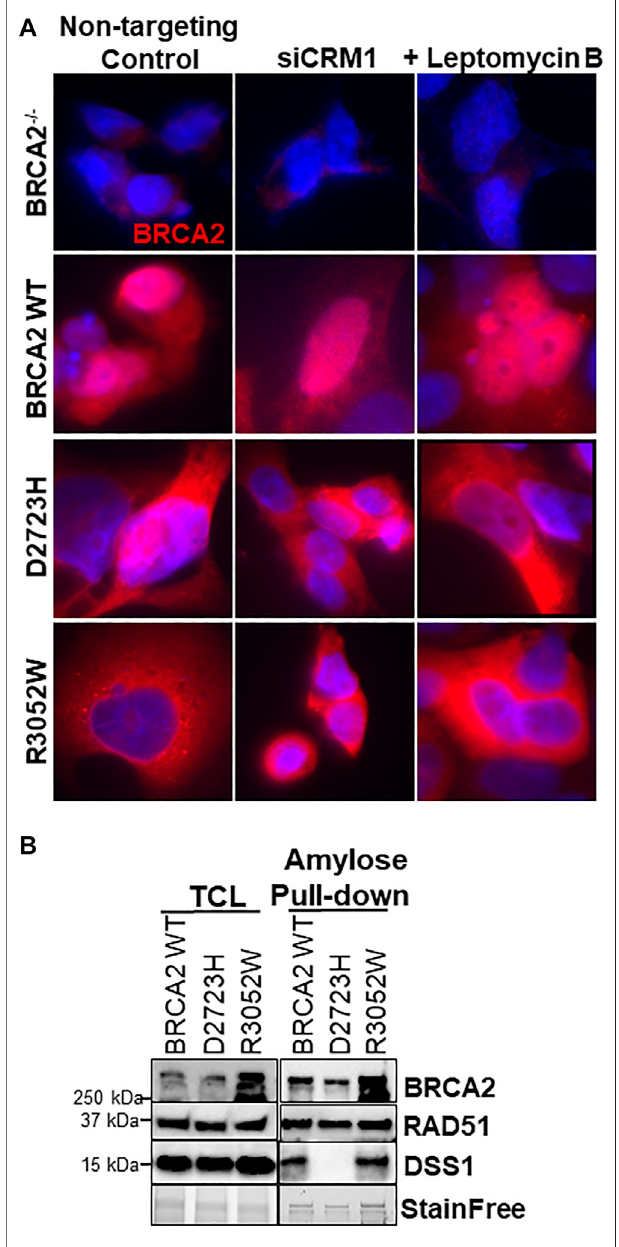
FIGURE 4 | R3052W cytoplasmic localization is not altered by CRM1 depletion or leptomycin treatment and retains binding to DSS1. (A) Immuno fl uorescent localization of BRCA2 in untreated stable cell lines expressing WT, D2723H, or R3052W BRCA2 proteins upon RNA interference-mediateddepletionofCRM1ortreatmentwiththenuclearexport inhibitor leptomycin B. Representative images of BRCA2 (red, MBP antibody) and DAPI staining to visualize nuclei (blue). (B) Western blots of total cellular lysates (TCL) and amylose pulldowns from HEK 293T cells transiently transfected with 2XMBP-BRCA2 WT, D2723H, or R3052W co-transfected with HA-DSS1. Anti-MBP antibody was used for BRCA2 detection, Anti- RAD51 antibody was used for endogenous RAD51 detection and Anti-HA antibody was used for DSS1